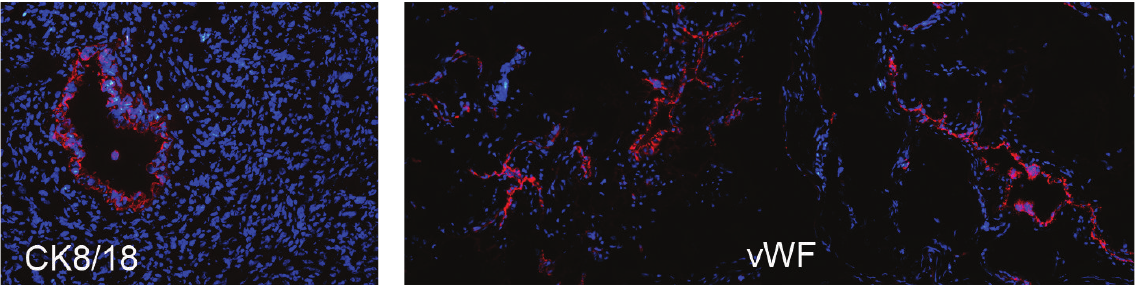
Figure 2: Immunofluorescence analysis of human endometriotic cysts. The frozen sections were stained with mAb anti-human vWF to highlight the vessels or with mAb anti-human CK 8/18 to show the glands. The binding of mouse monoclonal antibodies was revealed by the incubation with goat anti-mouse IgG Cy3-conjugated secondary antibodies. Nuclei were stained in blue by DAPI: original magnification